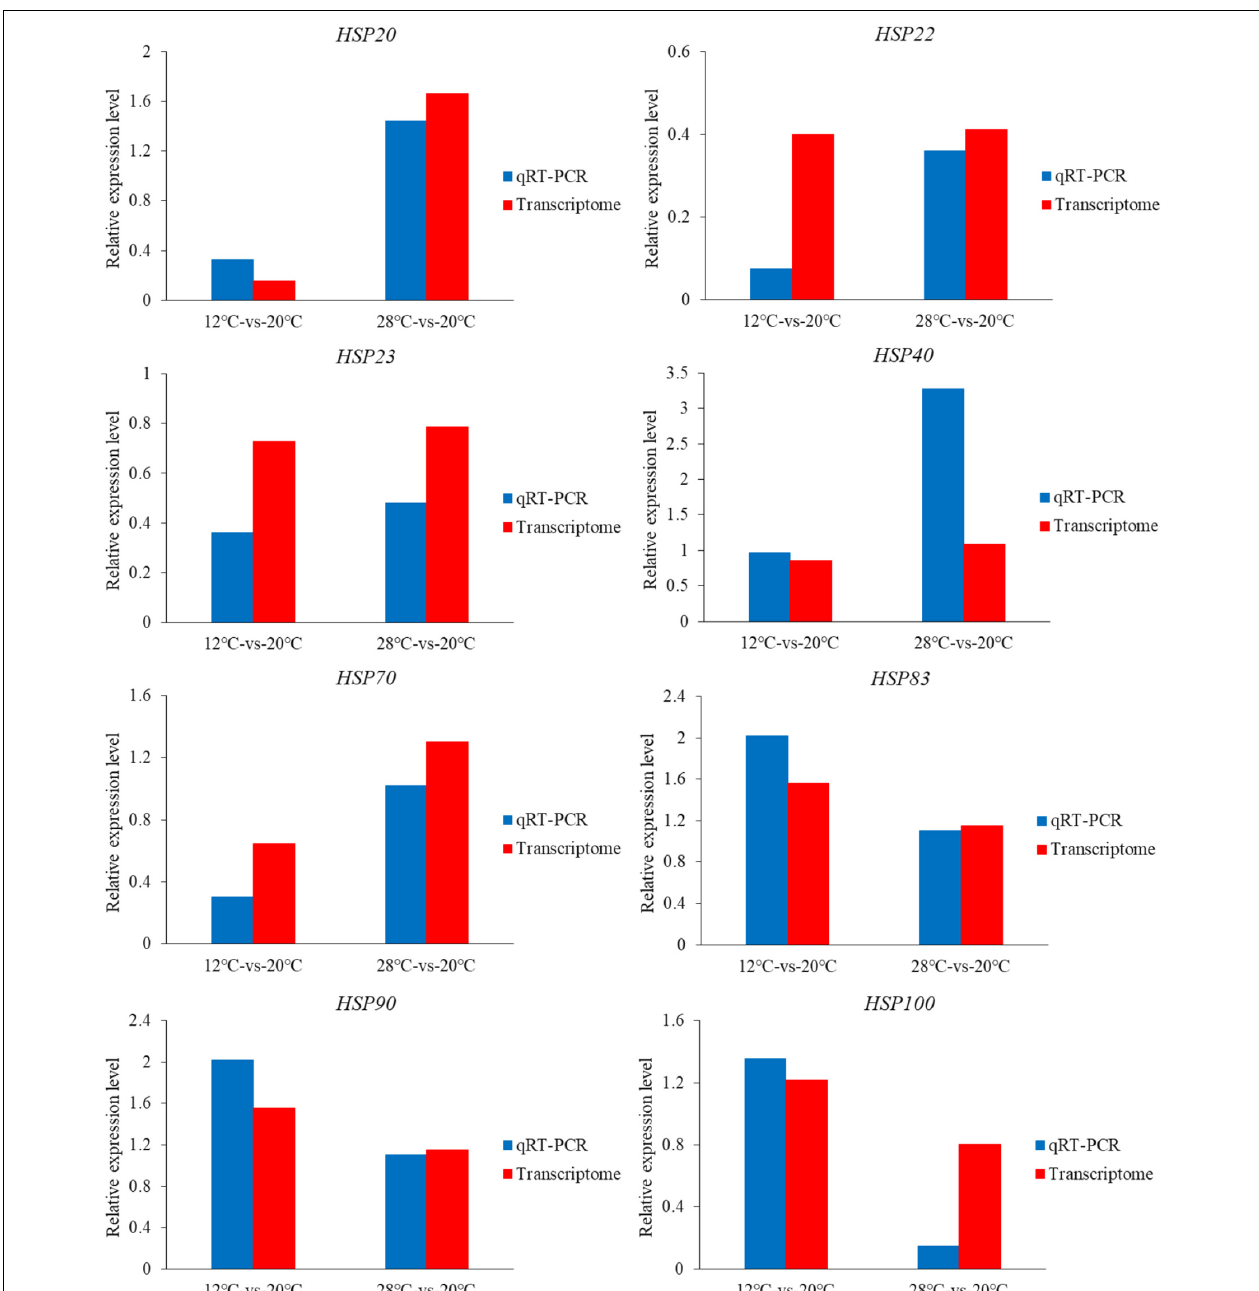
FIGURE 5 | Relative expression levels of eight HSP genes based on transcriptome data and qRT-PCR